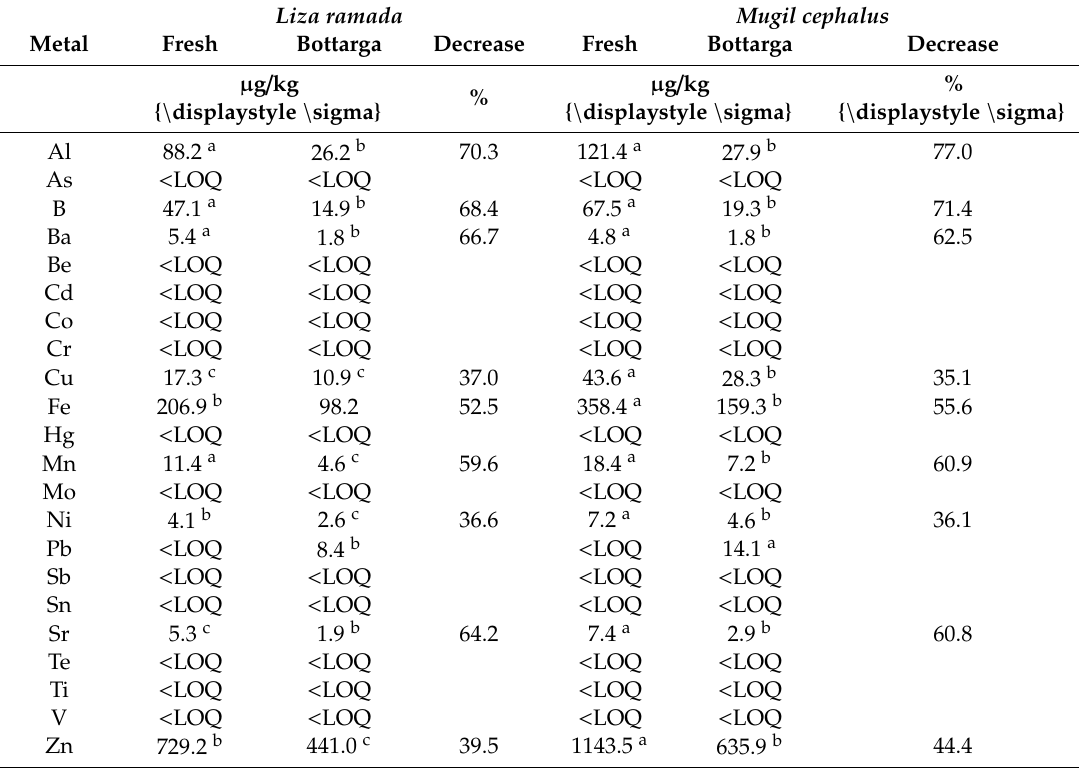
Table 3. Heavy metal composition ( µ g / kg FW) of fresh roe and bottarga of M. cephalus and L. ramada collected from Sardinia lagoon.